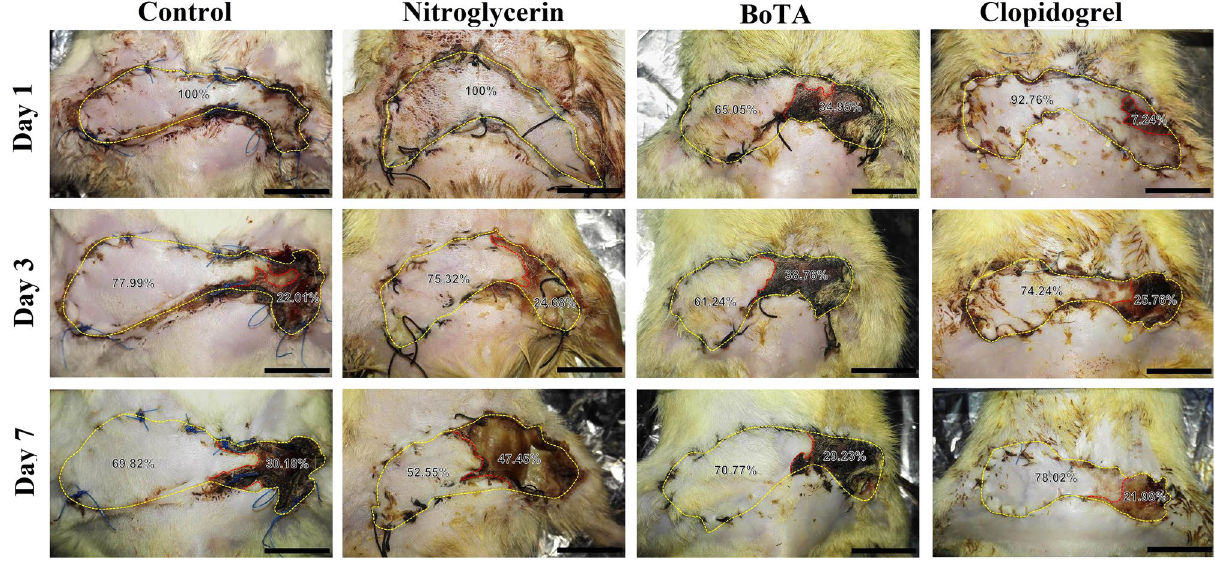
Figure 2. Gross appearance of skin flaps of the induced flap ischemia subgroups at days 1, 3, and 7 after the operation. The yellow dotted line outlines the total flap area and the demarcation between normal and necrotic tissues is indicated by the red dotted line. (Scale bar = 1.5 cm).